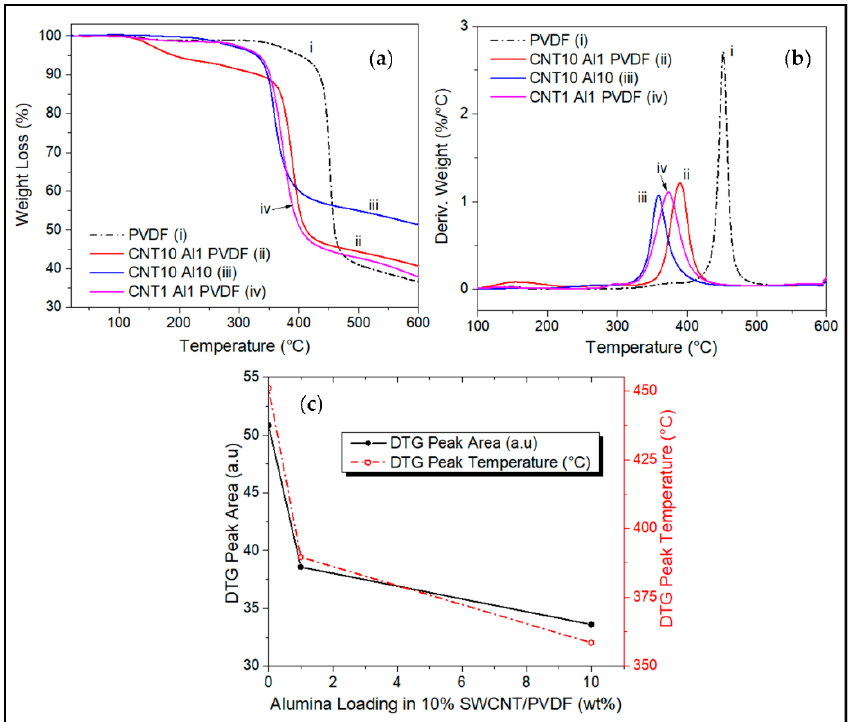
Figure 7. ( a ) TGA thermogram comparisons of effect of combinatorial CNT and Alumina wt.% loadings on decomposition of PVDF, with the respective ( b ) derivative weight curves. TGA test was carried out from room temperature to 600 ◦ C under N 2 atmosphere. ( c ) effect of composition on DTG peak area and peak temperature.